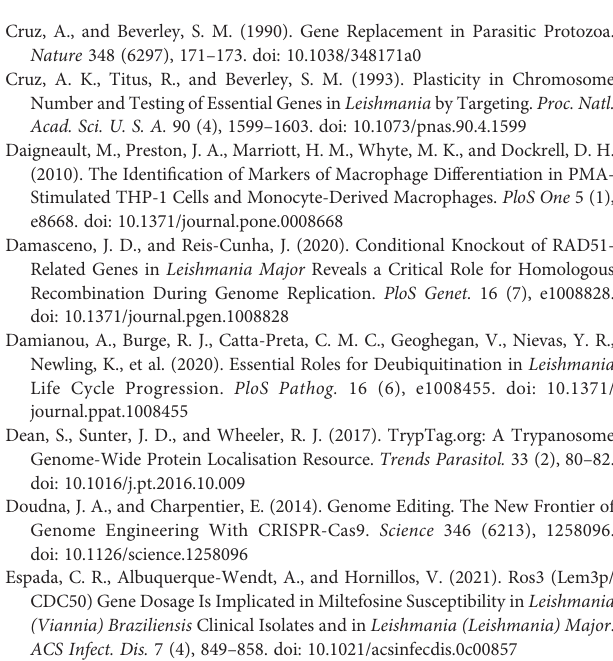
Supplementary Table 1 | List of the primers used in this